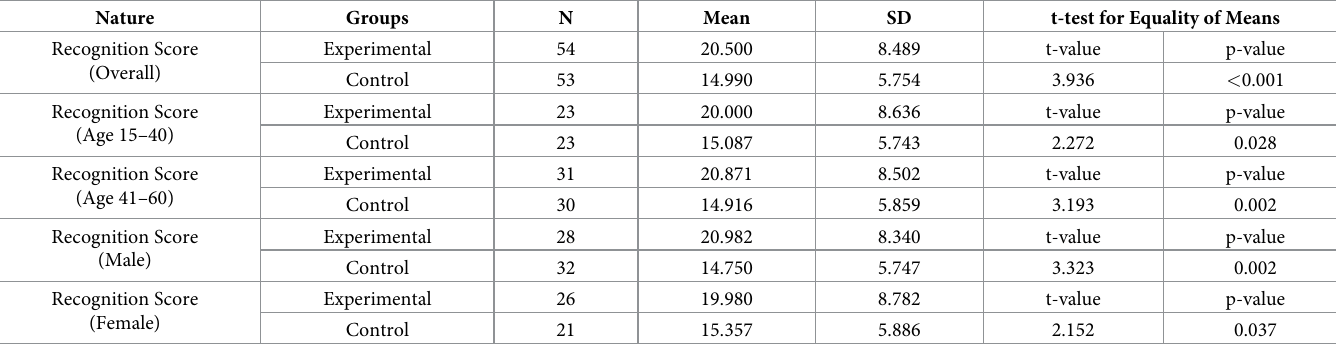
Table 4. Statistics of alphabet letter recognition scores of the experimental and the CG.